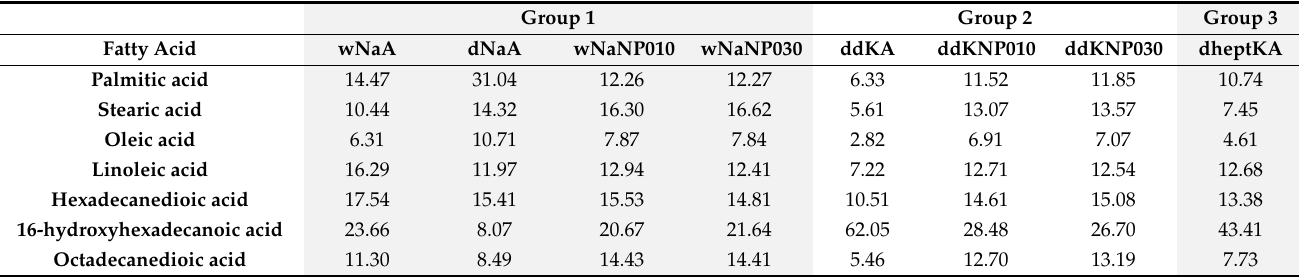
Table 5. GC-FID analysis of the constituents identified in cutin samples. Results are given as % (w fatty acid /w total selected fatty acids